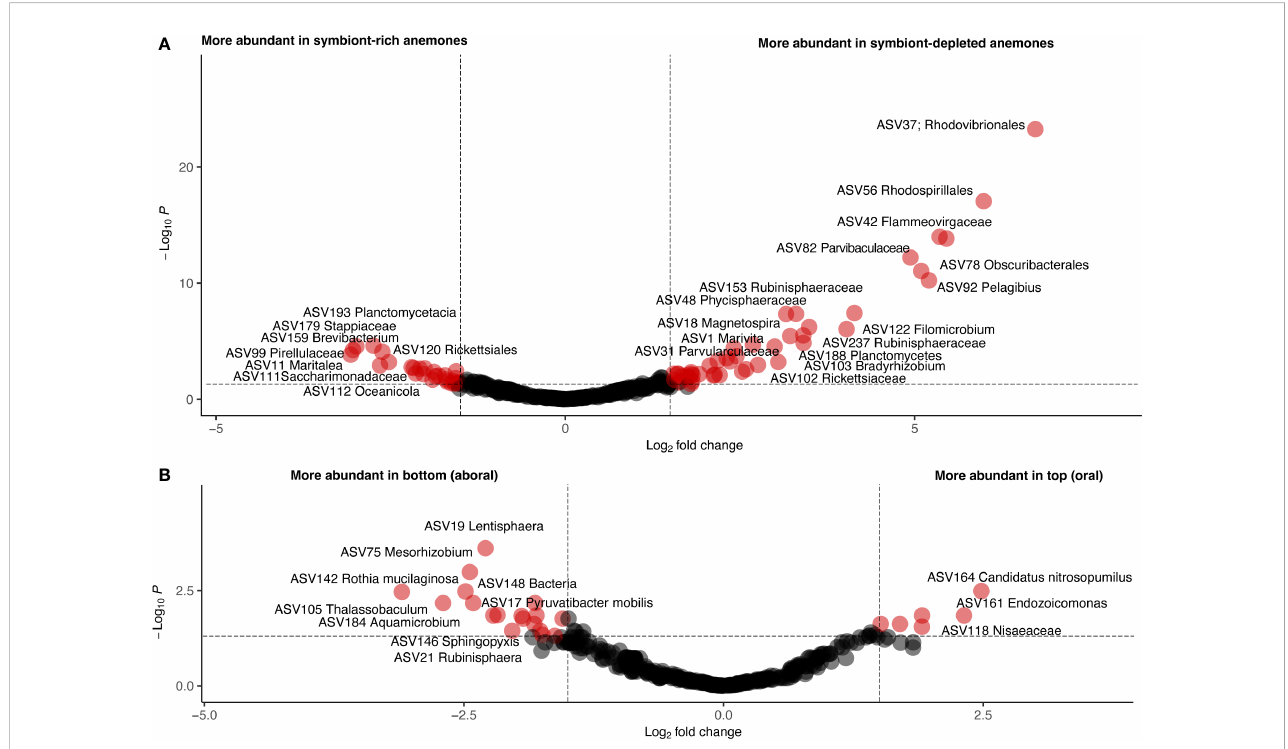
FIGURE 5 Volcano plots showing differentially abundant ASVs by symbiotic state (A) and body part (B) . Each circle represents one ASV. A p-value of 0.05 and a log2-fold change of 2 are indicated by dotted lines. ASVs meeting these thresholds are colored red and labeled with their assigned